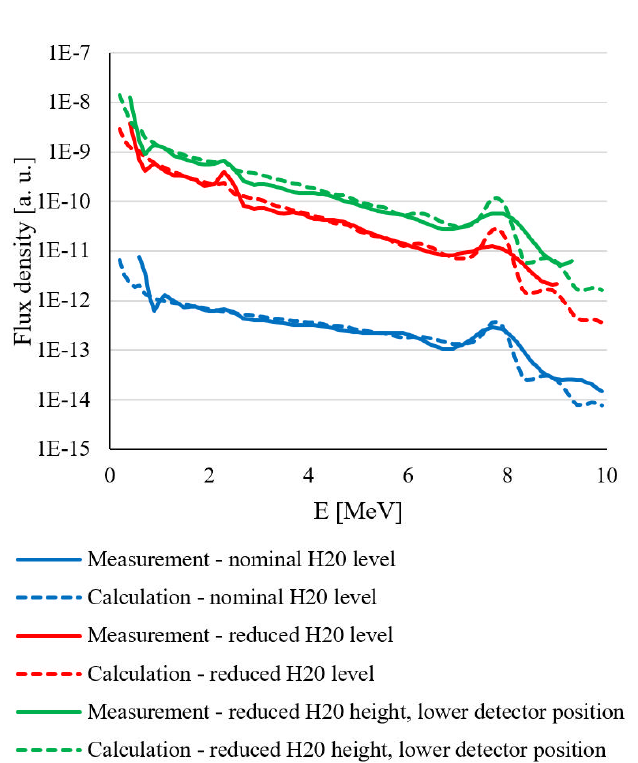
Fig. 8 Comparison of measured and normalized calculated gamma spectra for different moderator levels and detector positions The comparison for measured gamma spectrum with